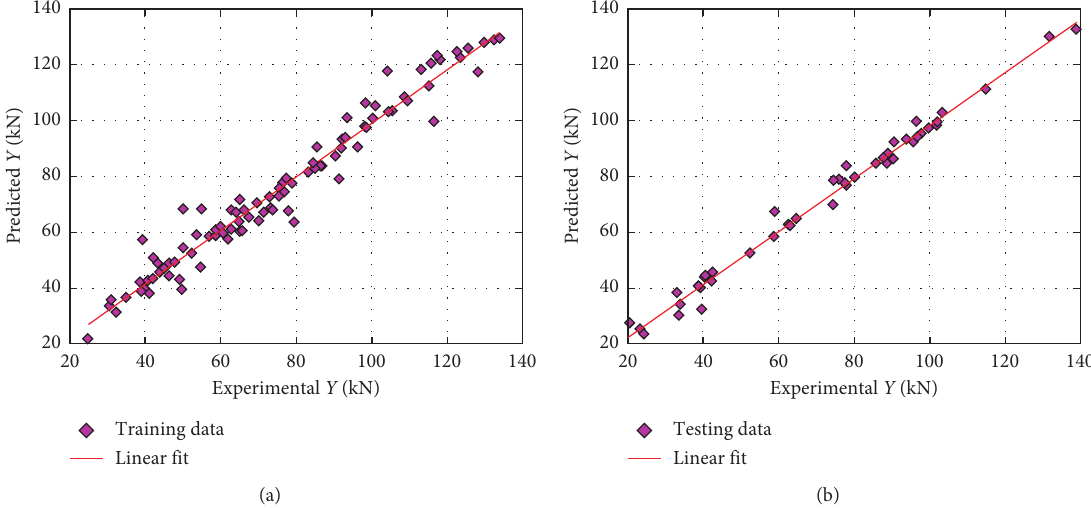
Figure 10: Regression graphs for the case of the best ANN architecture [9-1-1]: (a) training dataset and (b) testing